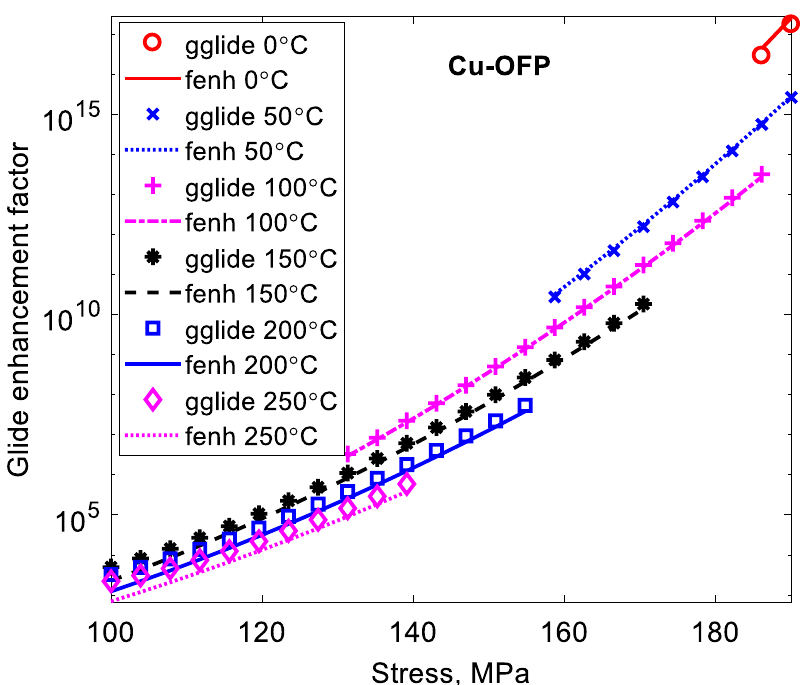
Figure 2. Comparison of the deformation induced increase in the vacancy concentration g climb , Equation (19), that raises the glide rate with the expression for the climb glide enhancement factor f enh , Equation (10). Results are presented for Cu-OFP at six temperatures.